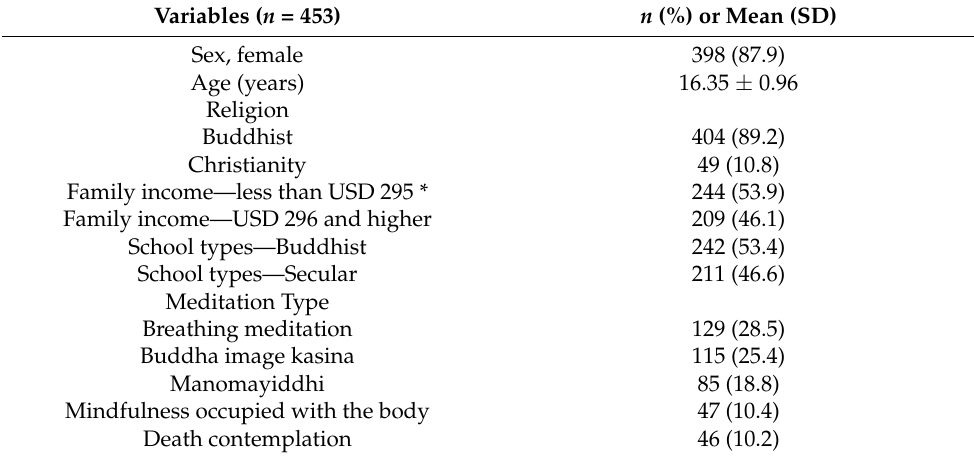
Table 1. Descriptive statistics of sample characteristics.